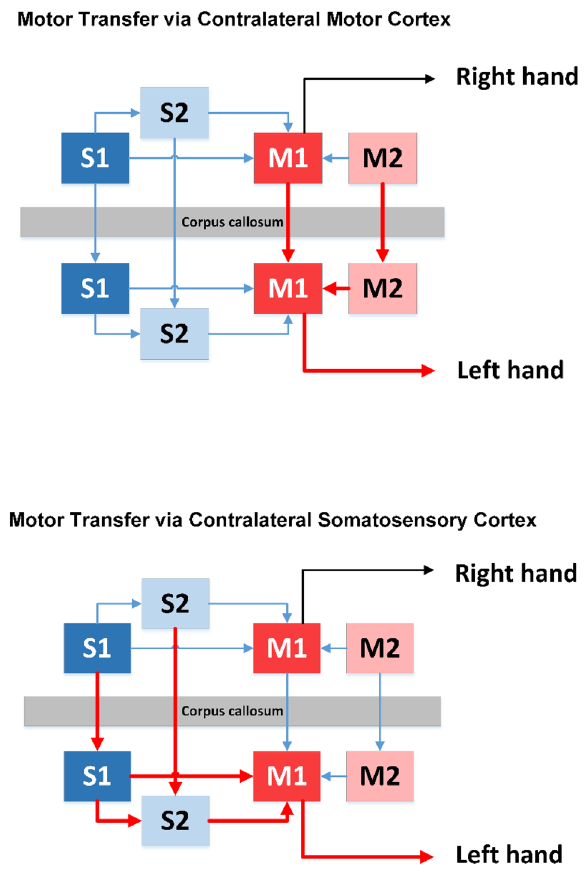
Figure 5. Possible neural pathways that explain the observed contralateral motor improvements. Top— Movement accuracy in the left hand can be observed through transcallosal projections between the homologous arm regions of left and right primary motor cortex controlling wrist motion. Bottom—Proprioceptive signals can be exchanged through transcallosal connections between the somatosensory cortices (S1 and S2) of each brain hemisphere and then transmitted to motor cortical neurons resulting in improved movement